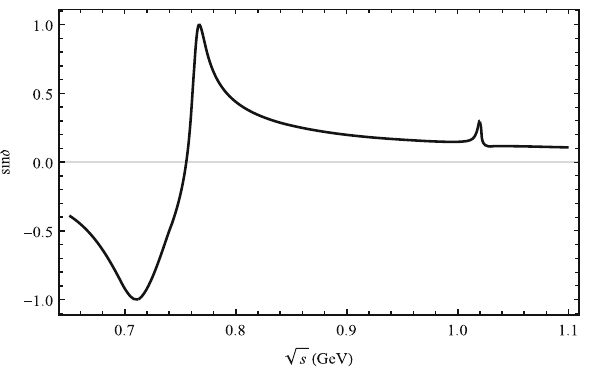
√ s corresponding to central